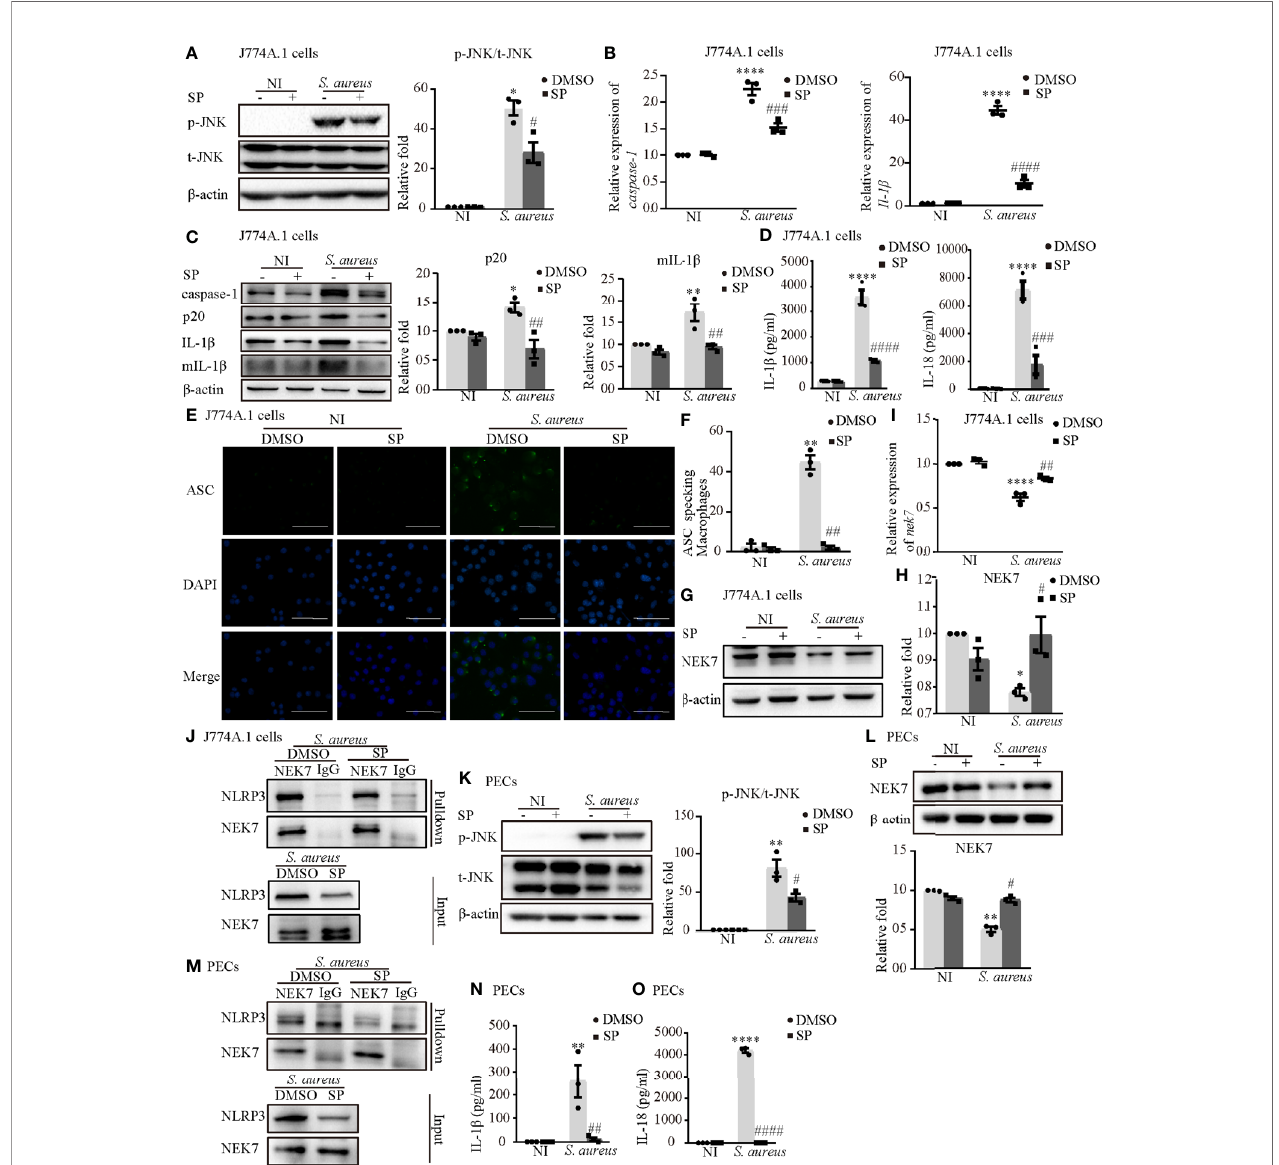
FIGURE 5 | Phosphorylated JNK activated the NLRP3 in fl ammasome by accelarating NEK7-NLRP3 compound formation upon S. aureus infection. J774A.1 cells (A – J) and PECs (K – O) pretreated with or without JNK inhibitor (SP 600125) at the fi nal concentration of 20 m mol/L for 2 h followed by S. aureus infecton (MOI of 1 or 5) for 24 h or 2 h. (A) The protein levels of t-JNK and p-JNK were detected by western blot and analyzed by relative densitometric quanti fi cation in J774A.1 cells and PECs (K) . (B) The mRNA expression levels of caspase-1 , Il-1 b were quanti fi ed by RT-PCR. (C) The protein expression levels of caspase-1, p20, pro-IL-1 b and mIL-1 b were examined by western blot and analyzed by relative densitometric quanti fi cation. (D) The supernatants were collected at 48 h after S. aureus infection. The levels of IL-1 b and IL-18 in supernatants were detected by ELISA in J774A.1 cells and PECs (N, O) . (E) Confocal immuno fl uorescence imaged endogenous ASC specks. Cells were fi xed and stained for ASC (Green), DAPI (Blue). (Scale bar: 100 µm.) (F) The percentage of J774A.1 cells with ASC specks were quanti fi cated. More than 200 cells from at least 5 different fi elds were counted for ASC speck formation. (G, H) The protein expression level of NEK7 was examined by western blot and analyzed by relative densitometric quanti fi cation in J774A.1 cells and PECs (L) . (I) The mRNA expression level of nek7 was examined by RT- PCR. (J) Coimmunoprecipitation analysis of NLRP3 interaction with NEK7 in J774.A cells and PECs (M) . Similar results were obtained in three independent experiments in data. Data shown are means ± SEMs; * P < 0.05, ** P < 0.01, **** P < 0.0001 vs. non-infection control group, # P < 0.05, ## P < 0.01, ### P < 0.001, #### P < 0.0001 vs . infection control